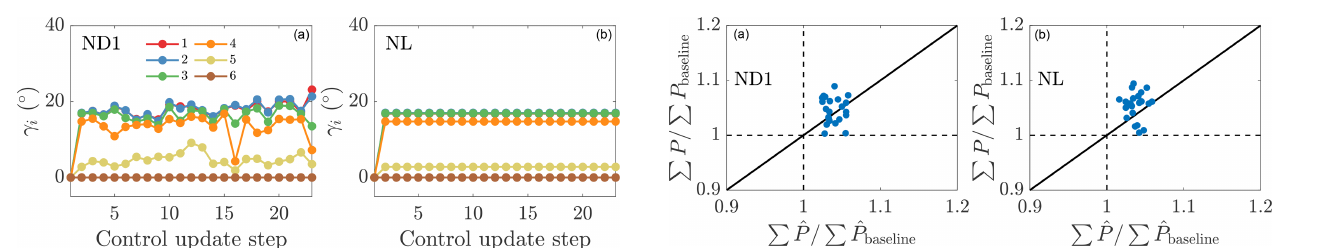
Figure 8. Wind farm yaw misalignment angles γ i for each turbine for (a) online control using the initial parameters to initialize the next state (ND1) and (b) the lookup table control (NL).